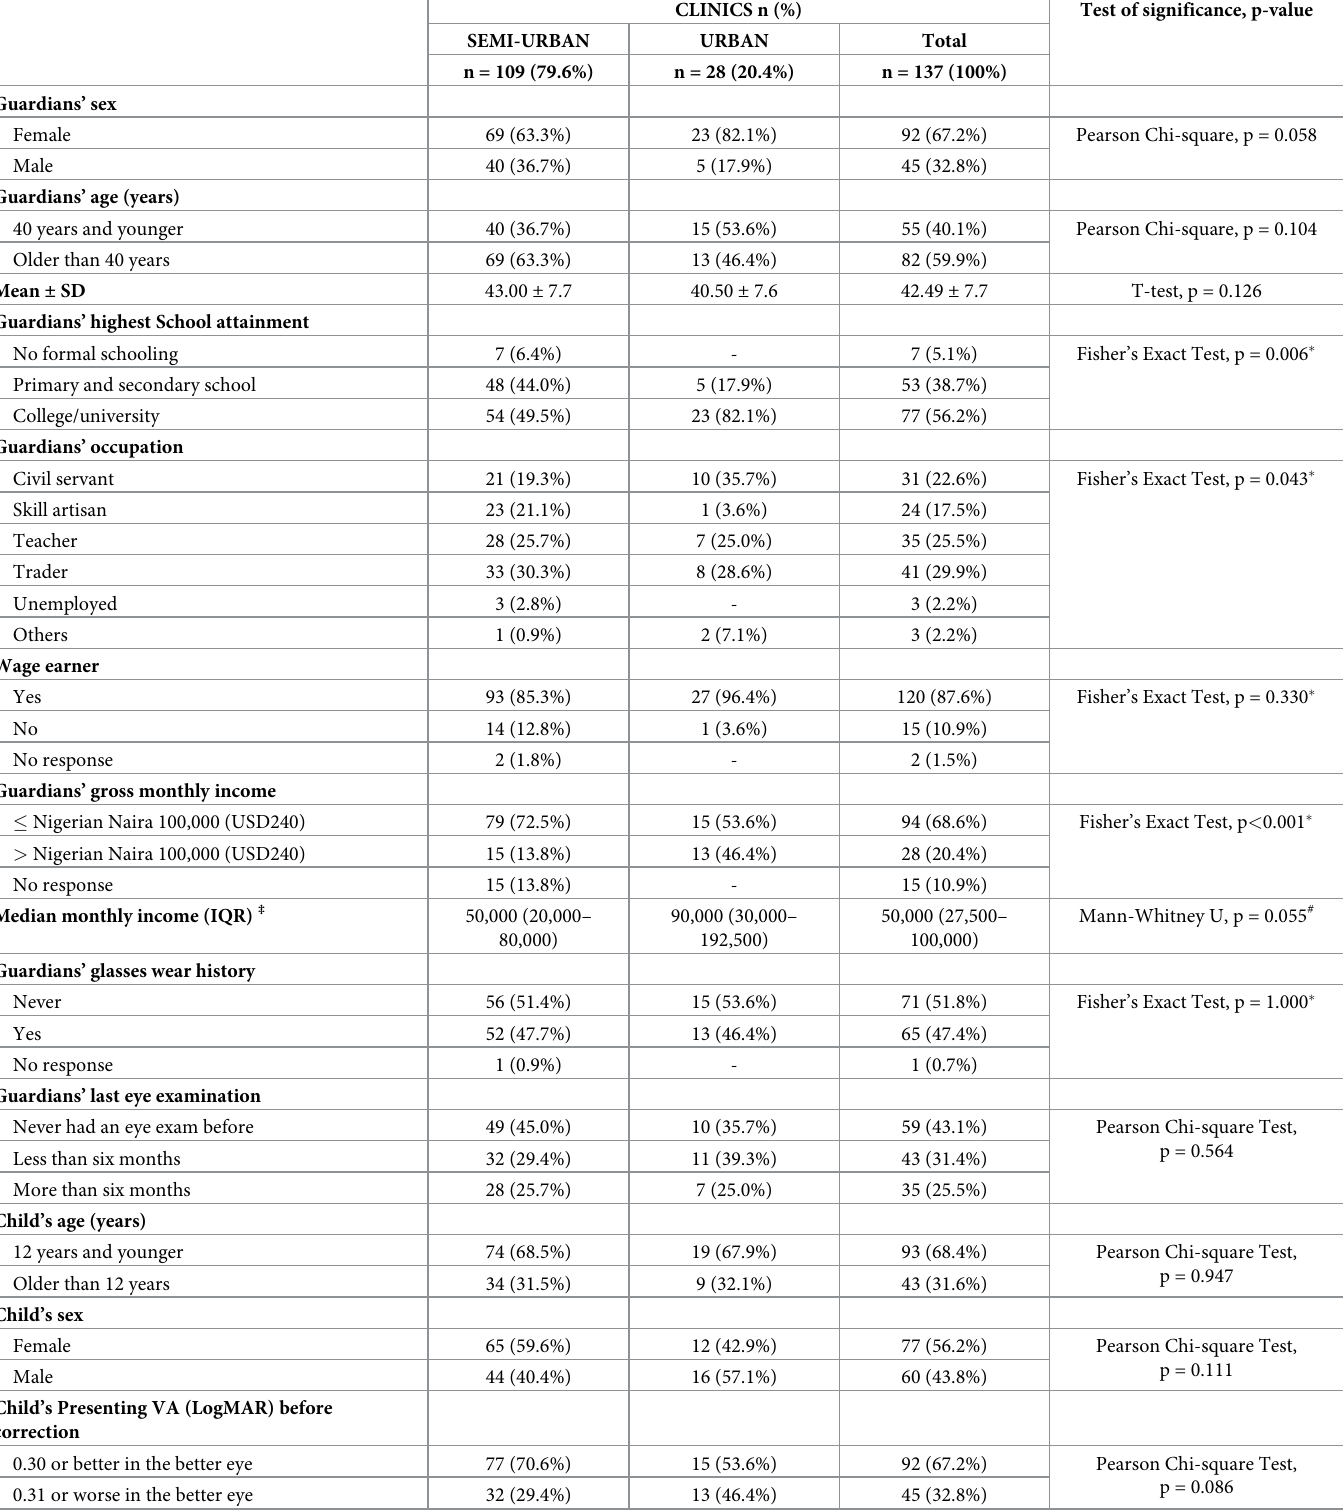
Table 1. Demography of participants from four eye clinics (n =